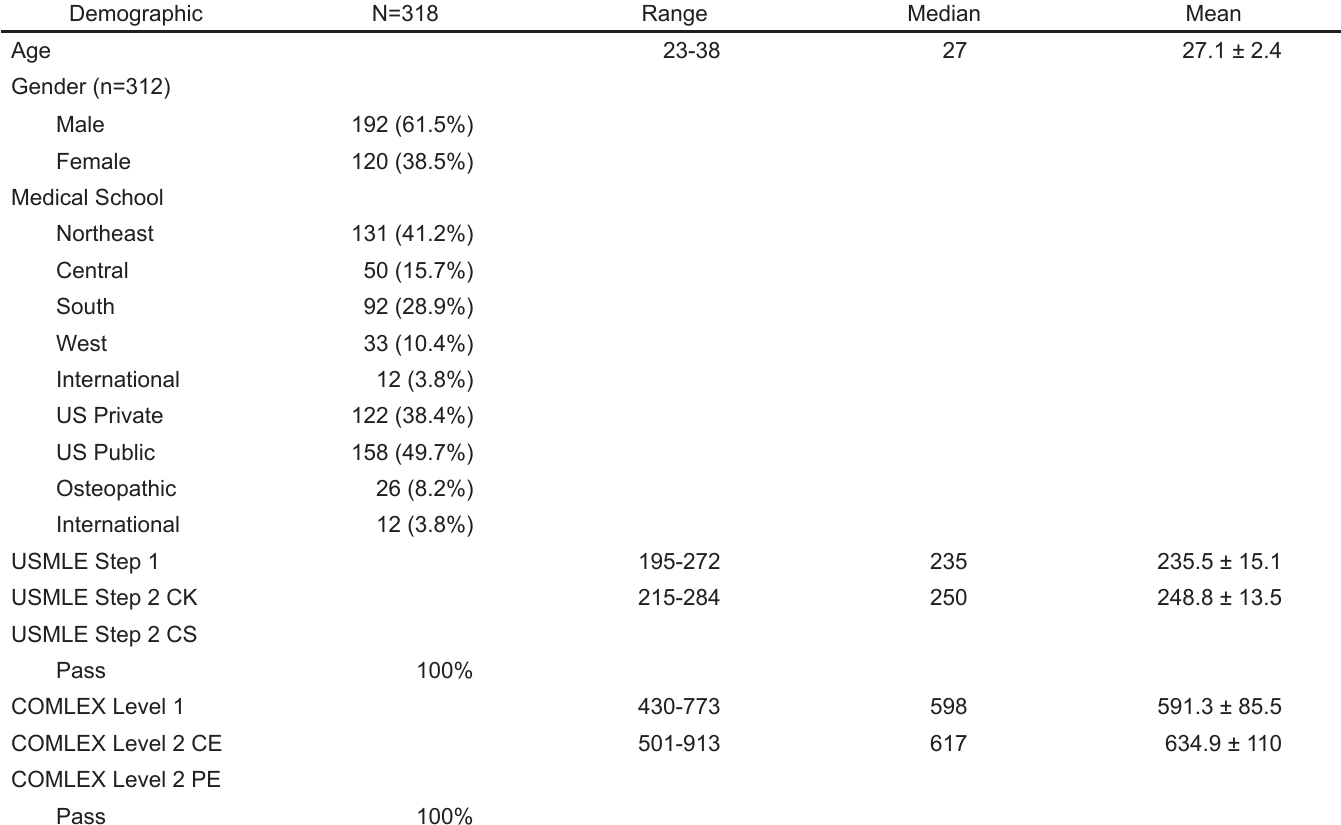
Table 2. Demographic data of residency